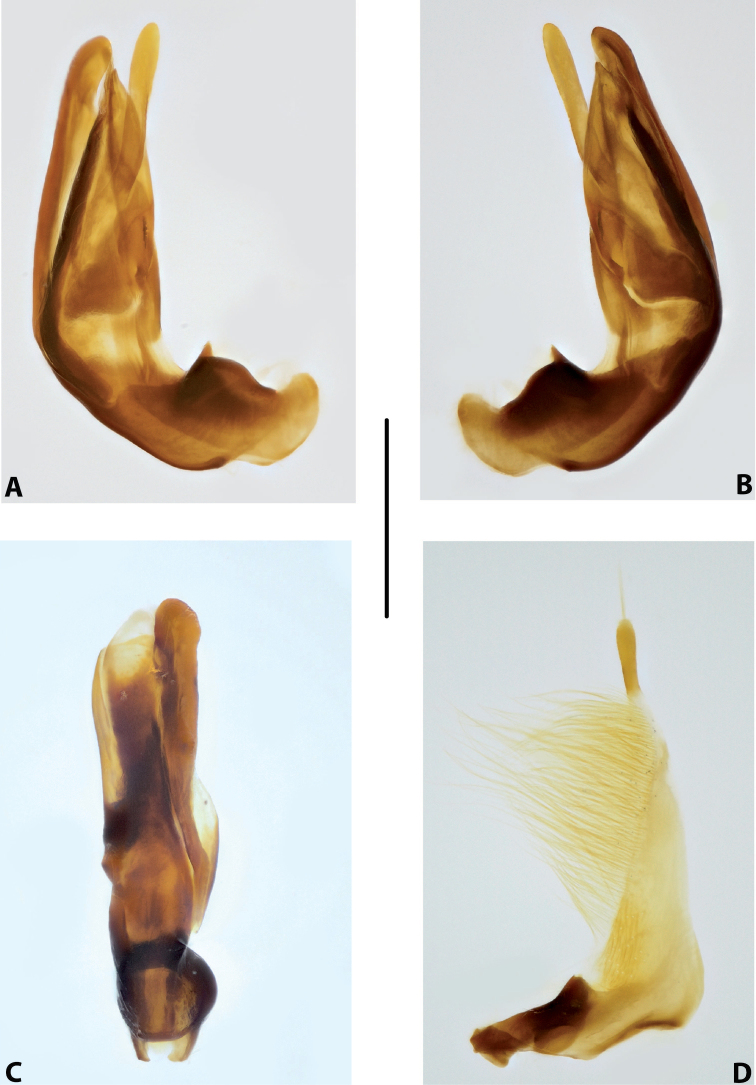
Copelatus
irregularisA median lobe in lateral view, right side B median lobe in lateral view, left side C median lobe in ventral view D left paramere in external view. Scale bar: 0.5 mm.